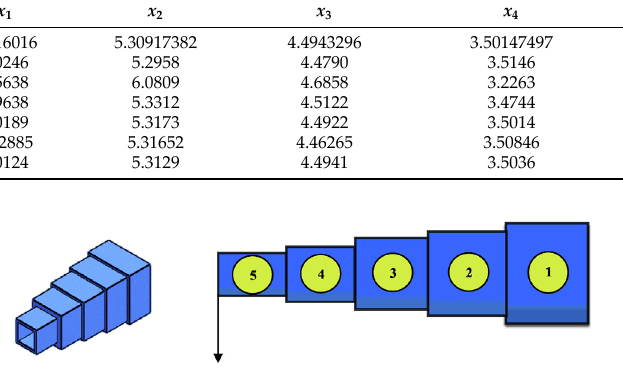
Figure 10. Design of a cantilever beam problem [80].